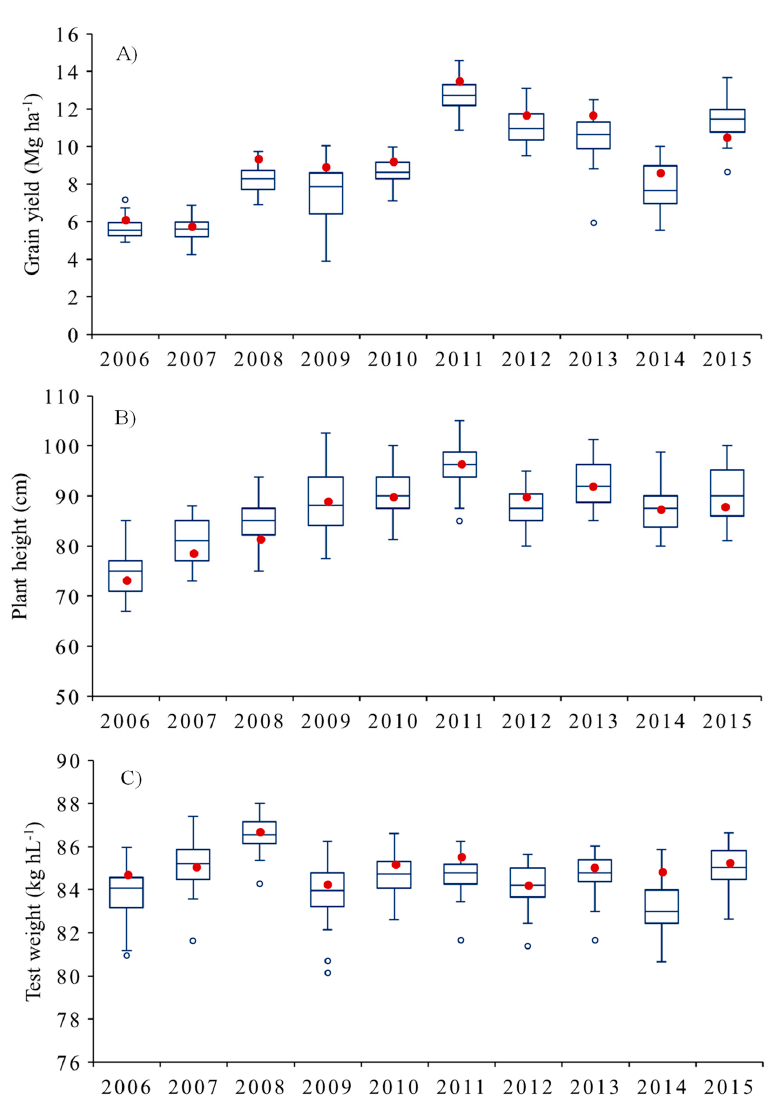
Figure 4. Grain yield ( A ), plant height ( B ) and test weight ( C ) for 40–46 advanced lines and cultivars of durum wheat grown under full irrigation in Santa Rosa, from 2006 to 2015. Box and whisker plots show the population minimum, 25th percentile / median / 75th percentile and maximum. The open symbols indicate outlier data and the closed symbols indicate the check cultivar ‘Corcolén’.